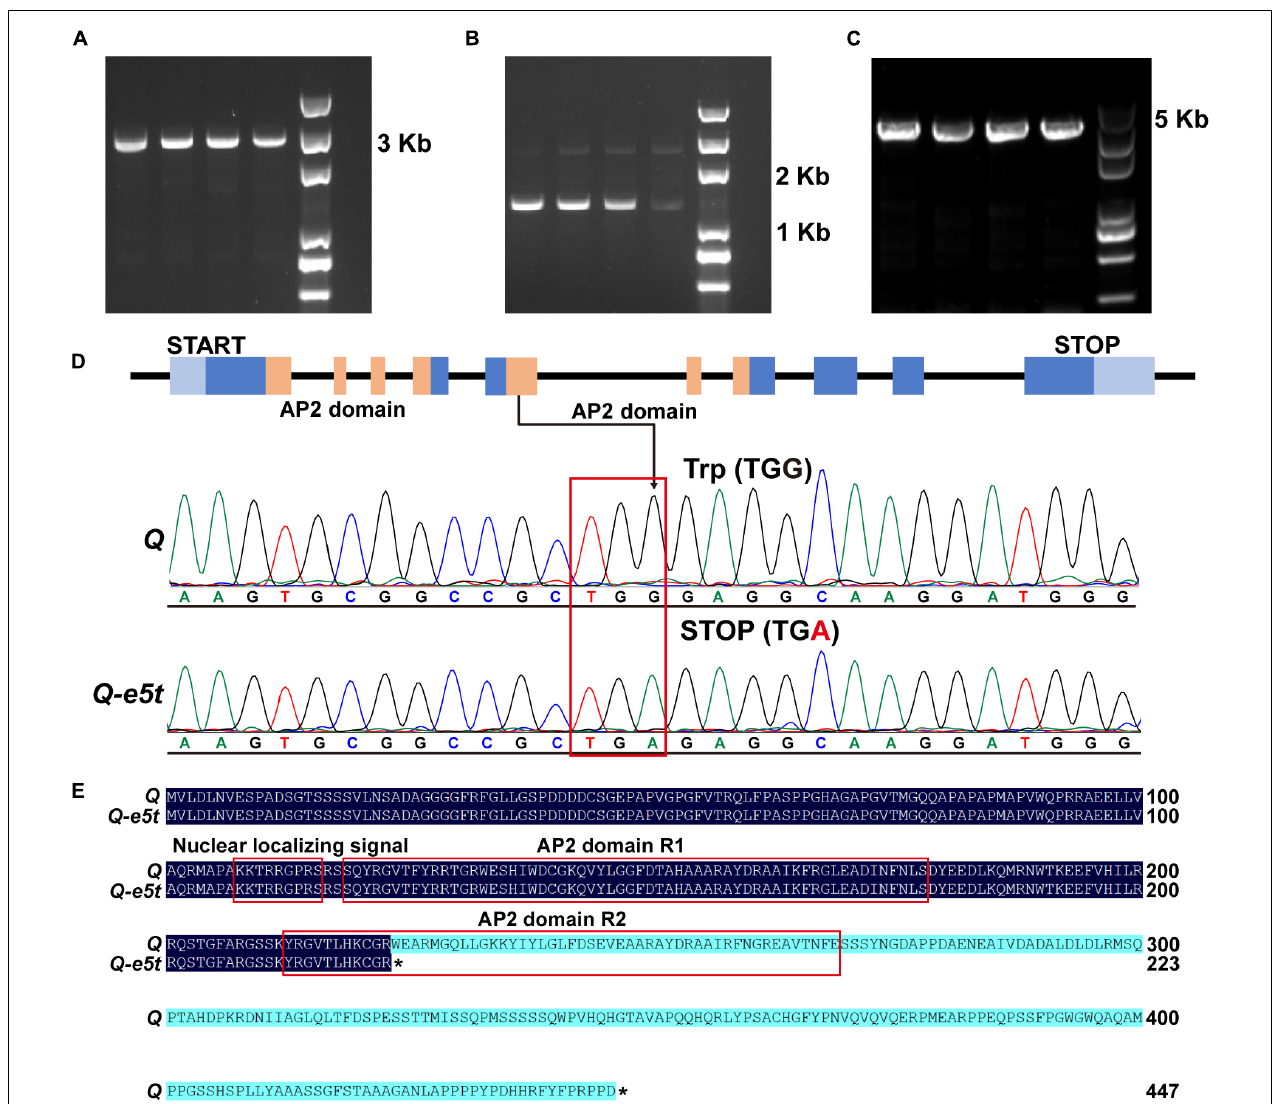
FIGURE 3 | Amplification of the Q gene and mutation detection. (A,B) Primers used to amplify the full-length sequence of the 5AQ gene. (C) Primers used to amplify the full-length sequence of the 5Dq gene. (D) The G-to-A mutation existed in the Q-e5t allele. (E) Protein sequence alignment of the Q and Q-e5t alleles. * indicates the stop codon of each